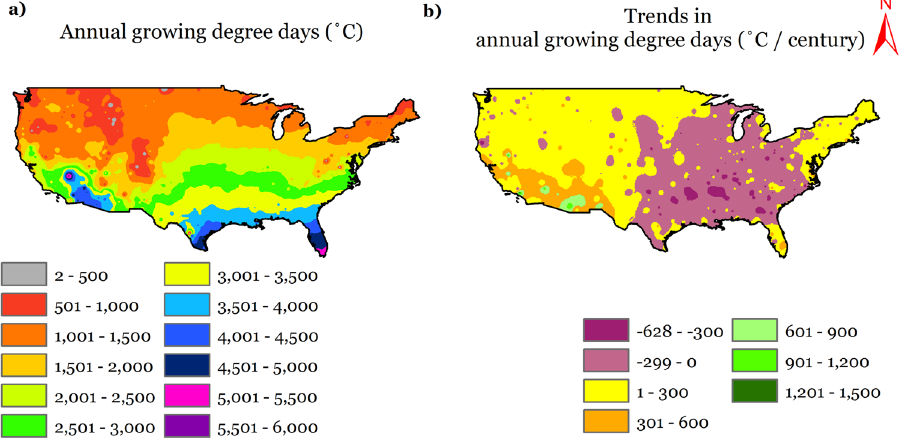
Figure 1. Map showing ( a ) spatial distribution of long-term average annual accumulated growing degree days (AGDD); ( b ) temporal trends in annual accumulated growing degree days during the period 1900–2014 across CONUS. We created the maps using ESRI ArcMap 10.4.1 software